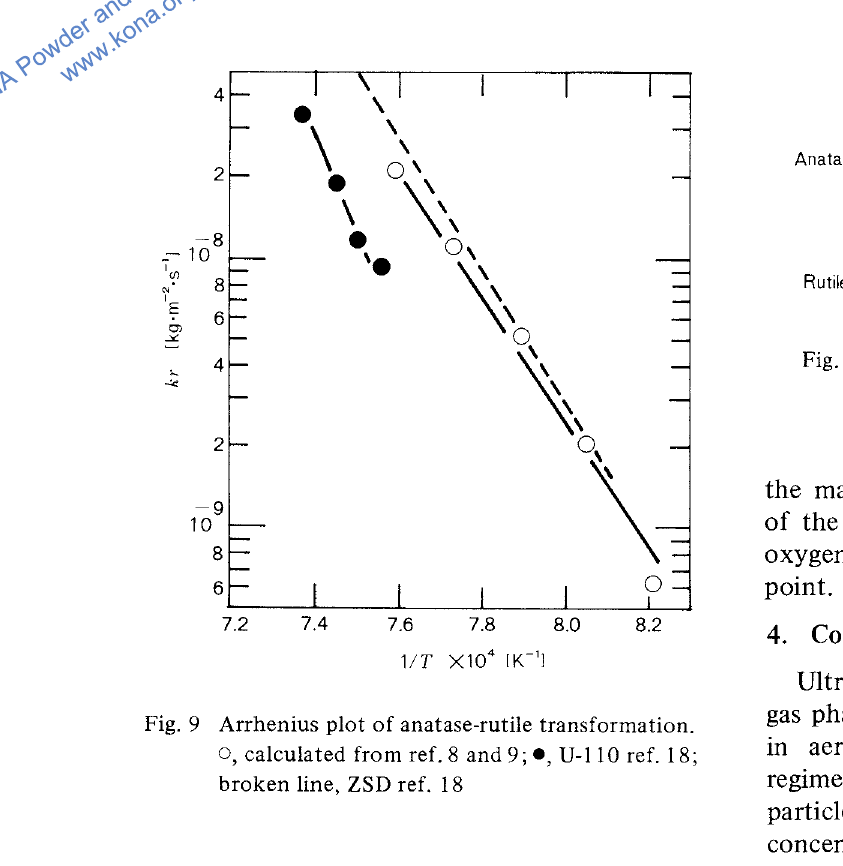
Fig. I 0 Schematic concept of transformation (Model